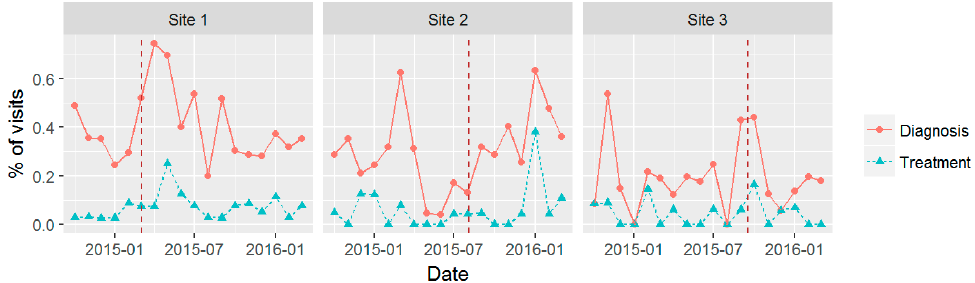
Figure 3. Assessment for alcohol use disorders (AUD): percentage (%) of visits with completed AUD Symptom Checklist by month, among providers implementing Behavioral Health Integration including the Sustained Patient-centered Alcohol-related Care (SPARC) program within three PC sites.